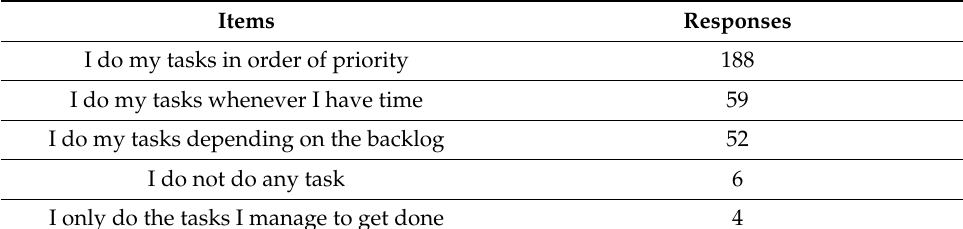
Table 3. Respondents’ Results on How they Deal with Tasks.